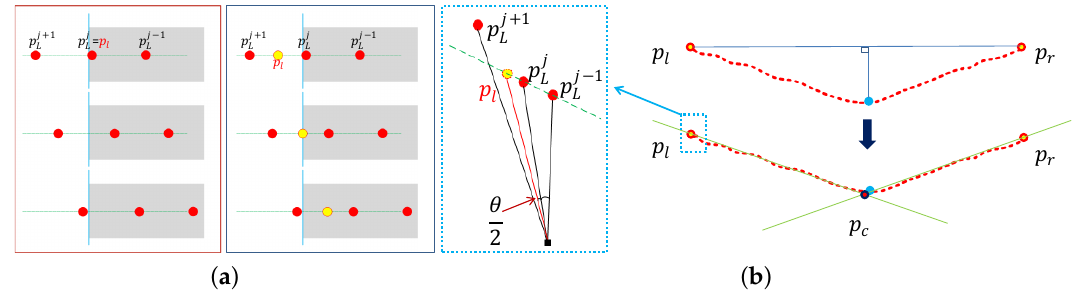
Figure 3. LiDAR feature definition and extraction: We used virtual points (yellow dots) instead of real LiDAR measurements (red dots) for our extrinsic calibration. ( a ) The left boundary point ( p j ) is L never exactly placed on the left edge line of the calibration board. Instead, we select a virtual point ( p l ) + 1 between the two consecutive points ( p j , p j ), located at the expected value of the edge line position L L (yellow dot). In the figure, the gray plane represents the calibration target, and the blue line describes the left edge line of the calibration target; ( b ) The virtual point ( p l ) is selected as a point that is placed on the intersection position of the angular mid-point and the line fitted to the left side LiDAR points. θ is the angular resolution of the LiDAR. The center point ( p c ) is selected as the intersection of the left and right fitted